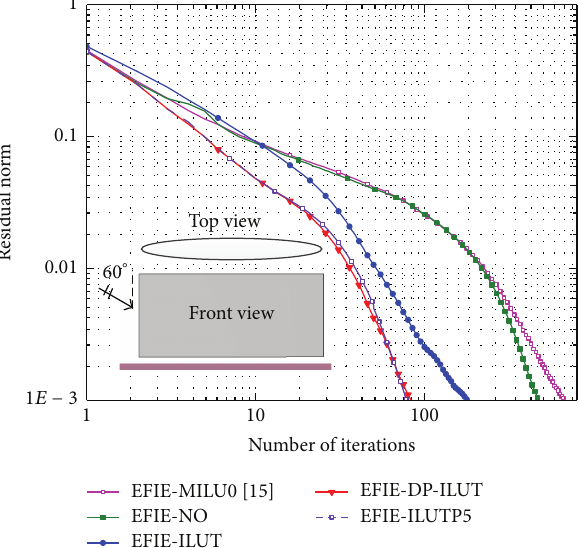
Figure 5: The convergence history of GMRES algorithms with differentintegraloperatorsandpreconditionersintheopenelliptical cavity example. Both the top view and the front view of the open elliptical cavity are